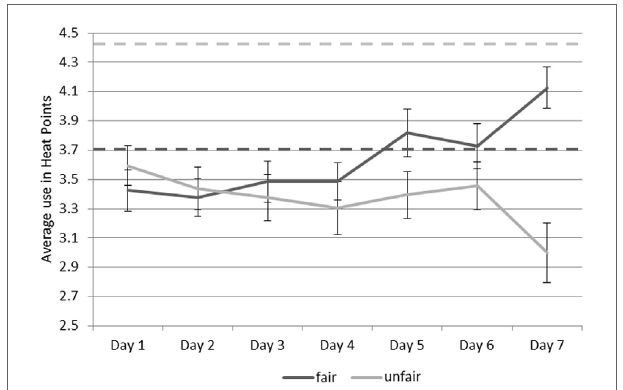
FigUre 1 | average use of energy on each day of the week in fair and unfair condition . Error bars represent SE of the mean. Dotted lines show manipulated groups’ average (fair versus